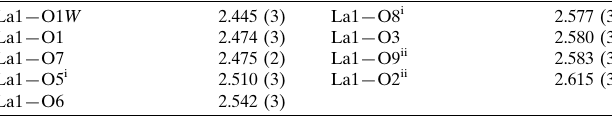
Selected bond lengths (A˚ ).